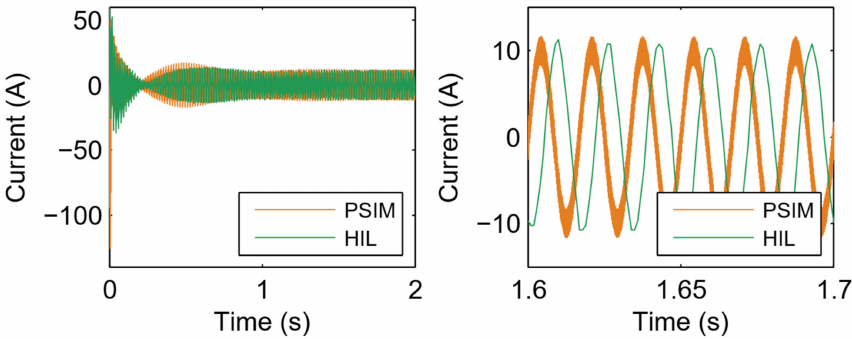
Figure 27. i a response under closed loop and inverter mode